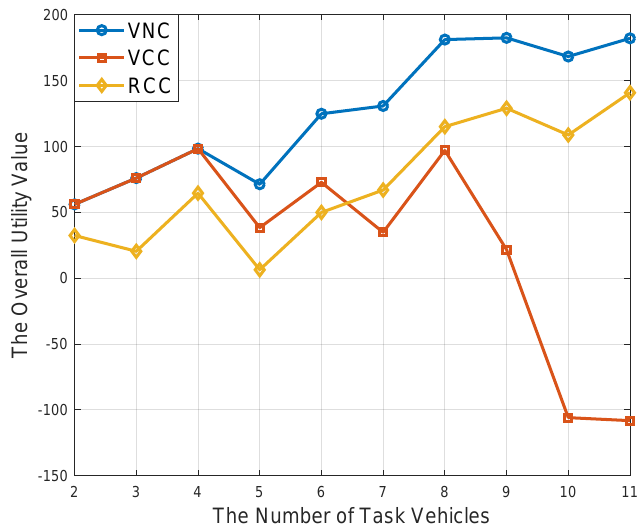
Figure 9. The performance of cognitive vehicular networks (CVN), vehicular cloud computing (VCC), and remote cloud computing (RCC) schemes.